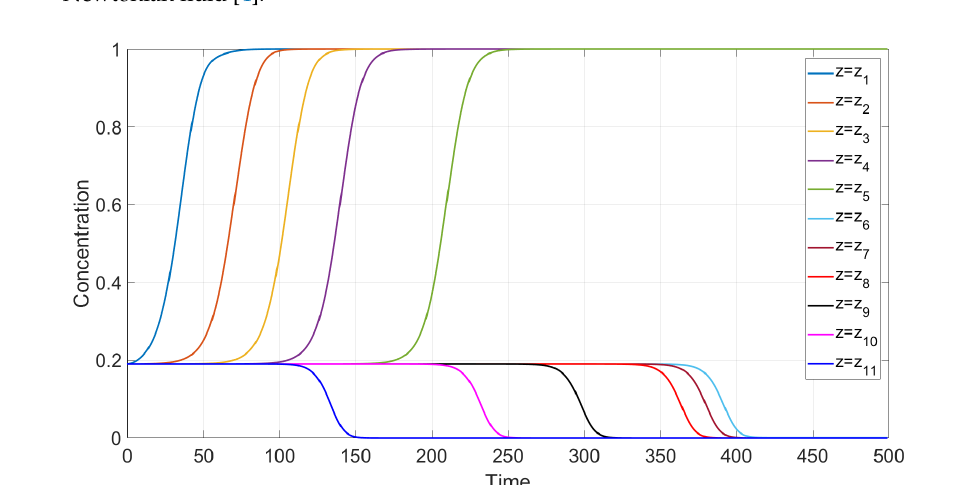
Figure 5. Calculated values of mean concentration versus time at different vertical locations for the flux F rz , with m =